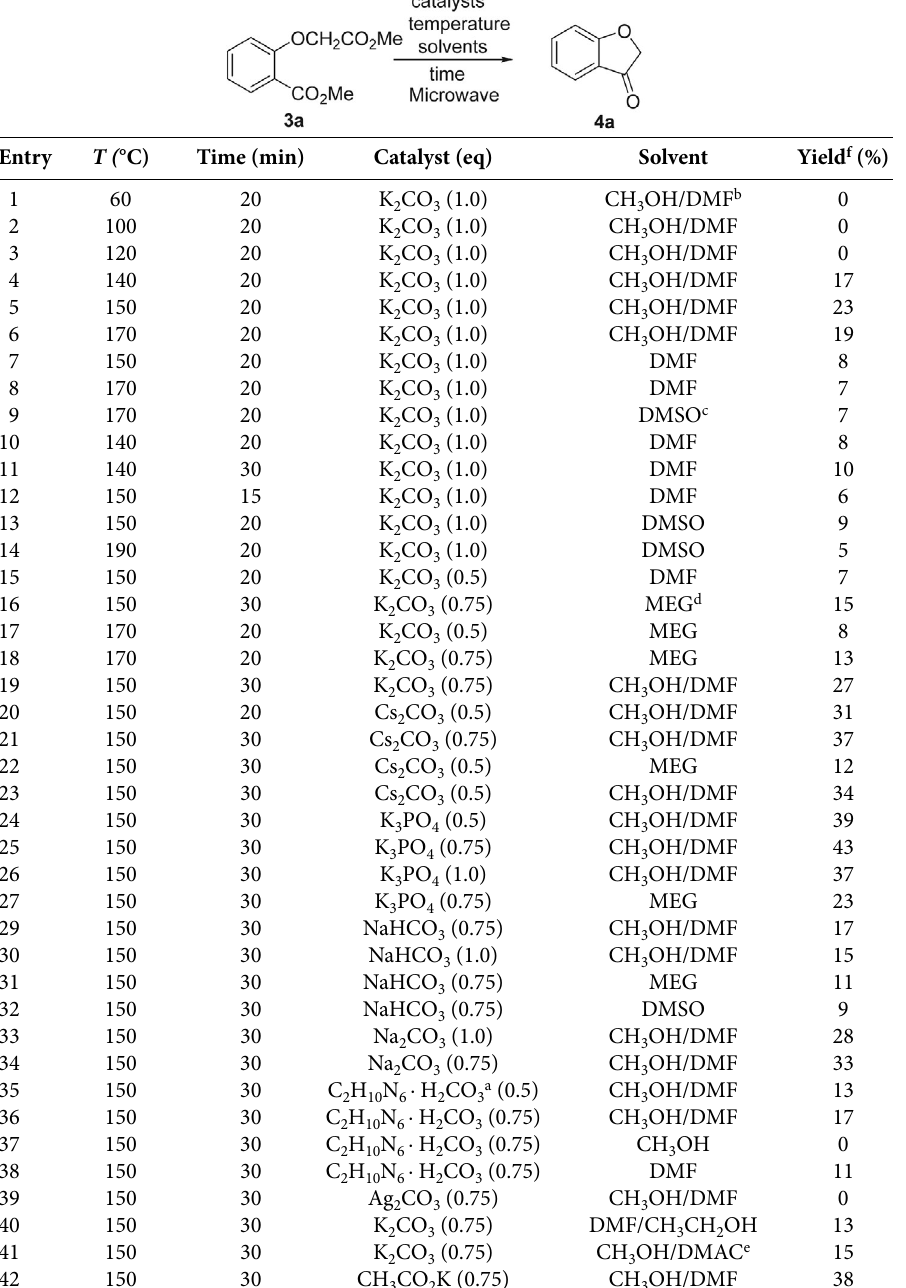
Table 1: Optimization of Reaction Conditions for Microwave-assisted Synthesis of